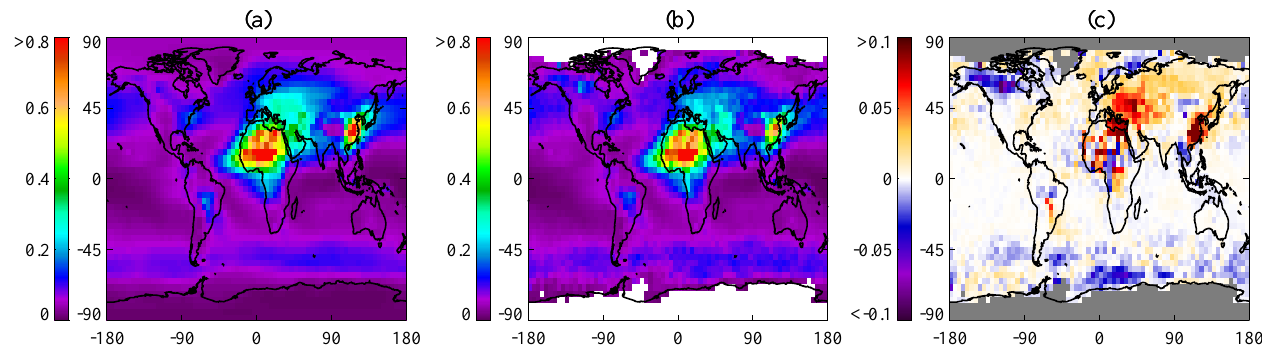
Fig. 1. Annual mean 550nm AOD field from GEOS-Chem (at 5 ◦ longitude by 4 ◦ latitude resolution), generated for all data in (a) and by averaging only those days with coincident AATSR observations in (b) . The difference between the two (“all data” – “any GlobAerosol data”) is shown in (c) .